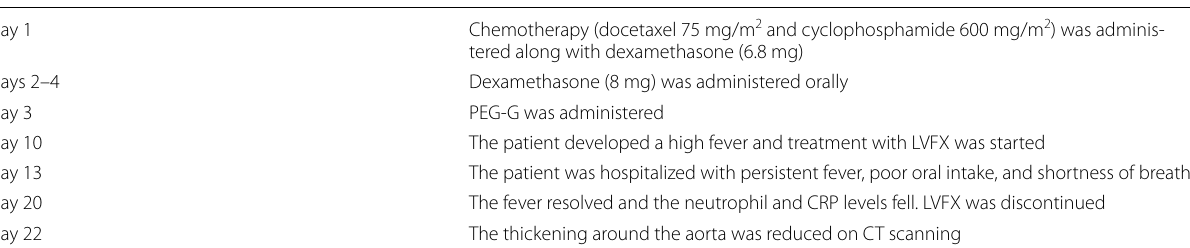
Table 2 Timeline of patient